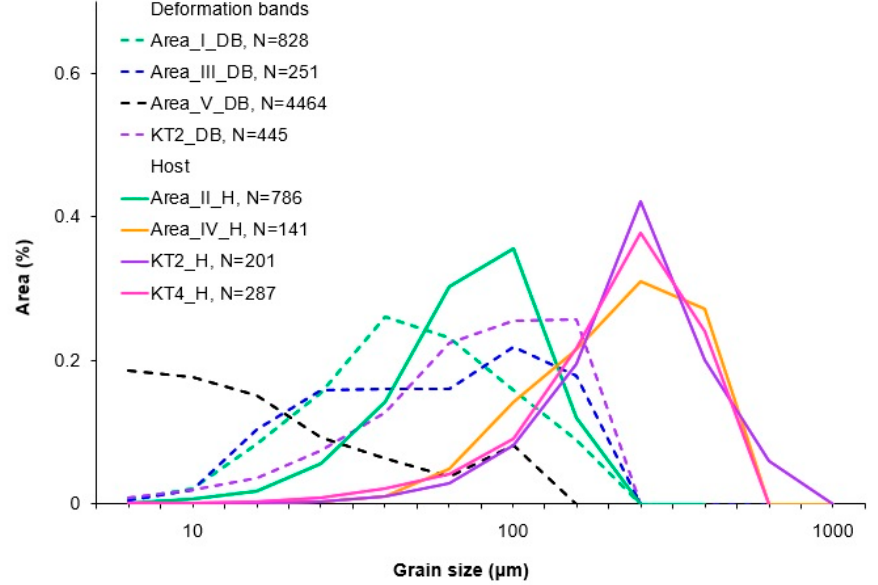
Figure 9. An example of the grain outline data acquired with GIMP. Sample B6_8.2 m_Area V_DB. ( a ) Microphotograph of the deformation bands area (cross-polarized light). ( b ) Acquisition of grain boundaries with GIMP.